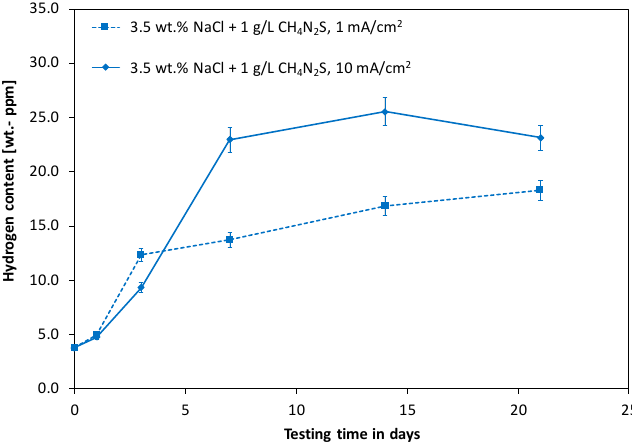
Figure 3. Hydrogen charging results for two different current densities, both at room temperature.